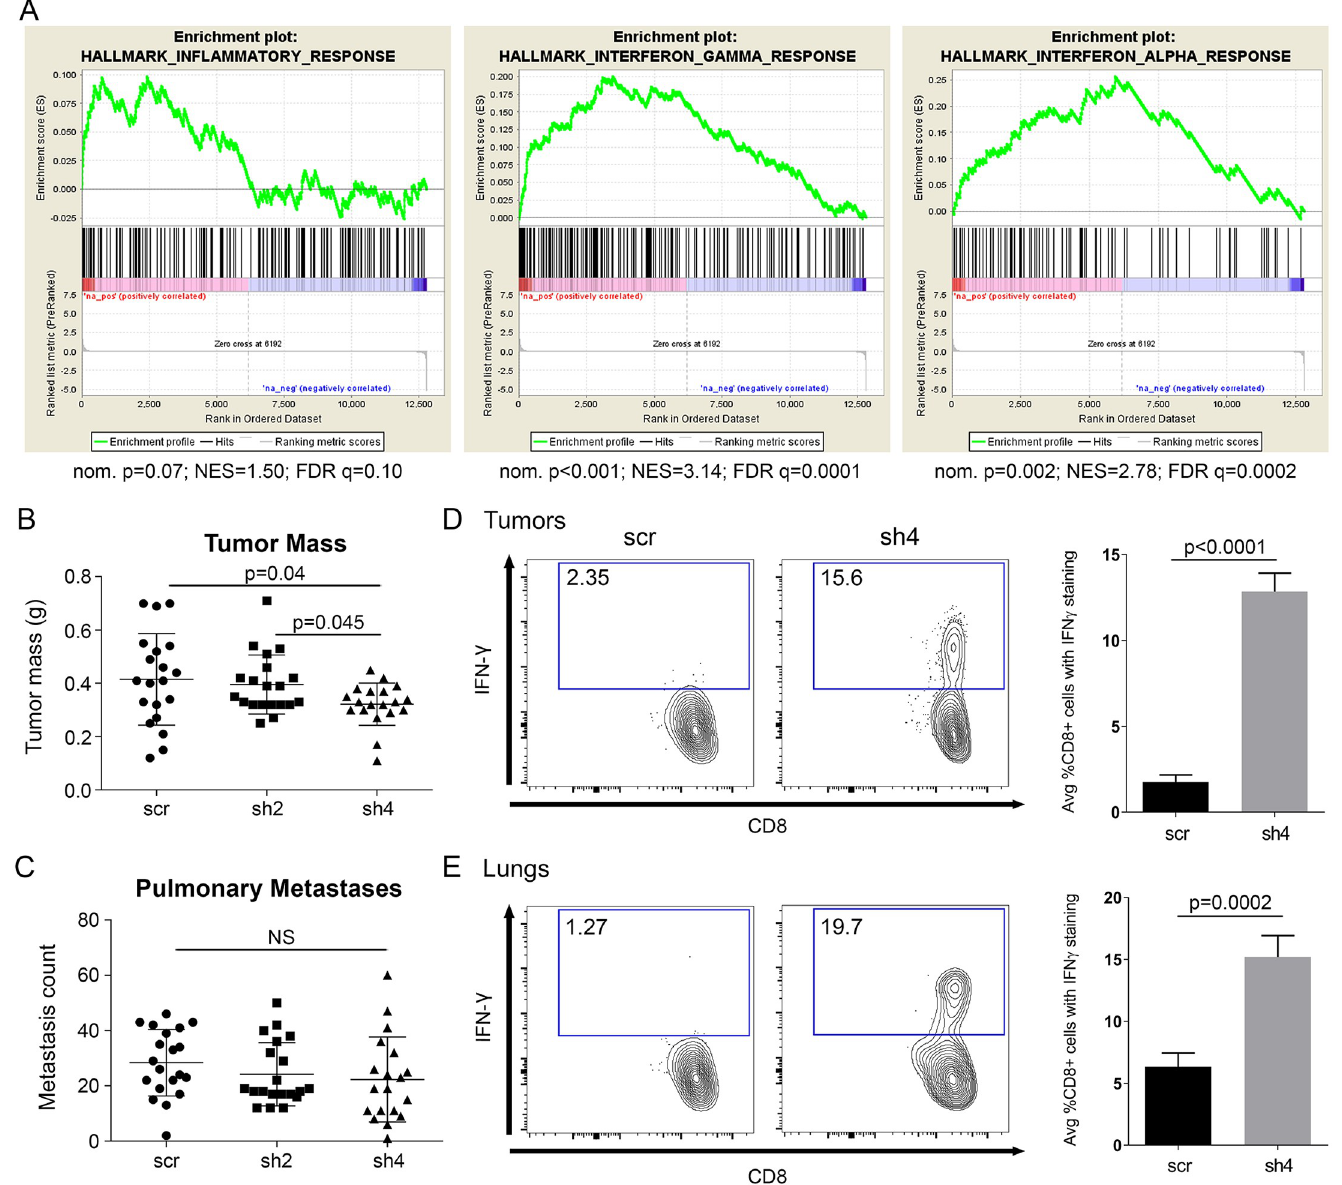
Fig 4. T cells mediate the effect of Rnaseh2c knockdown on metastasis. (A) GSEA analysis of RNA-sequencing data comparing sh4 with scr tumors in hallmark pathways related to inflammation and interferon signaling. nom. p: nominal p-value; NES: normalized enrichment score; FDR q: false discovery rate q-value. (B) Tumor mass in athymic nude mice that received Mvt1 cells with a knockdown of Rnaseh2c ; average ± standard deviation. (C) Metastasis counts for the mice from (B); average ± standard deviation, n = 20 mice per group in two independent experiments. (D) Proportion of Interferon γ (IFN- γ )-producing CD8+ T cell that were isolated from tumors of FVB mice that received orthotopic injection with either scr or sh4 cells; average ± SEM. (E) Proportion of Interferon γ (IFN- γ )-producing CD8 + T cell that were isolated from metastatic lungs of the mice shown in (D); average ± SEM. n = 5 mice per group with samples from each mouse analyzed in triplicate. NS—not